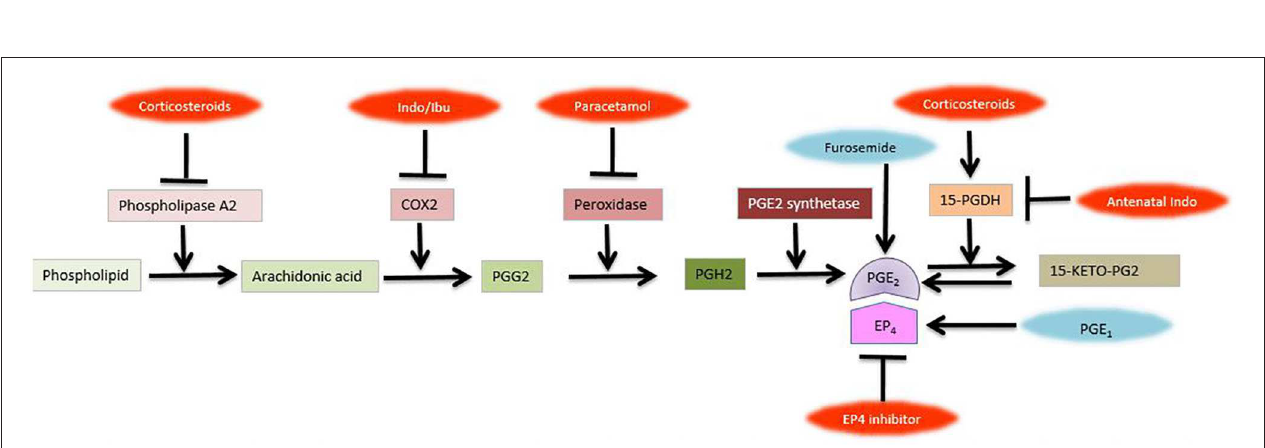
FIGURE 2 | Prostaglandin pathway and metabolism. Inhibitors of various steps are shown in red., COX-1, cyclooxygenase-1; EP4, Prostaglandin receptor 4; Indo, Indomethacin; Ibu, Ibuprofen; PG, prostaglandin; 15-PGDH, 15-hydroxyprostaglandin dehydrogenase; 15-KETO-PG2 (Figure courtesy of Fahri Ovali).